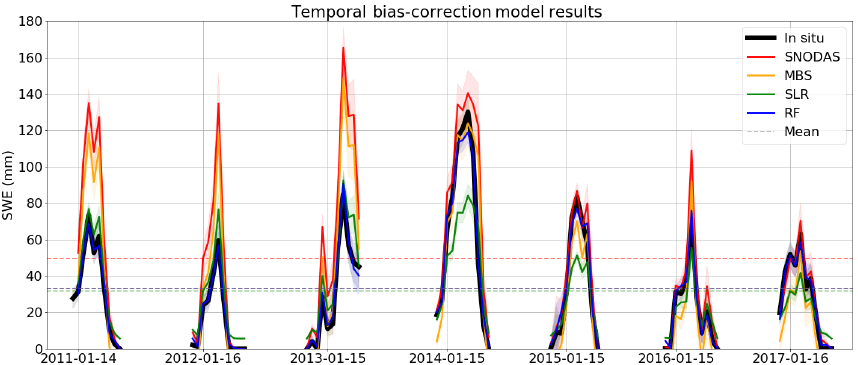
Figure 5. Daily mean SWE on the ground for the MBS, SLR and RF bias-corrected datasets, the default SNODAS SWE dataset and in situ SWE records. Shaded areas represent 95% confidence intervals based on the region data